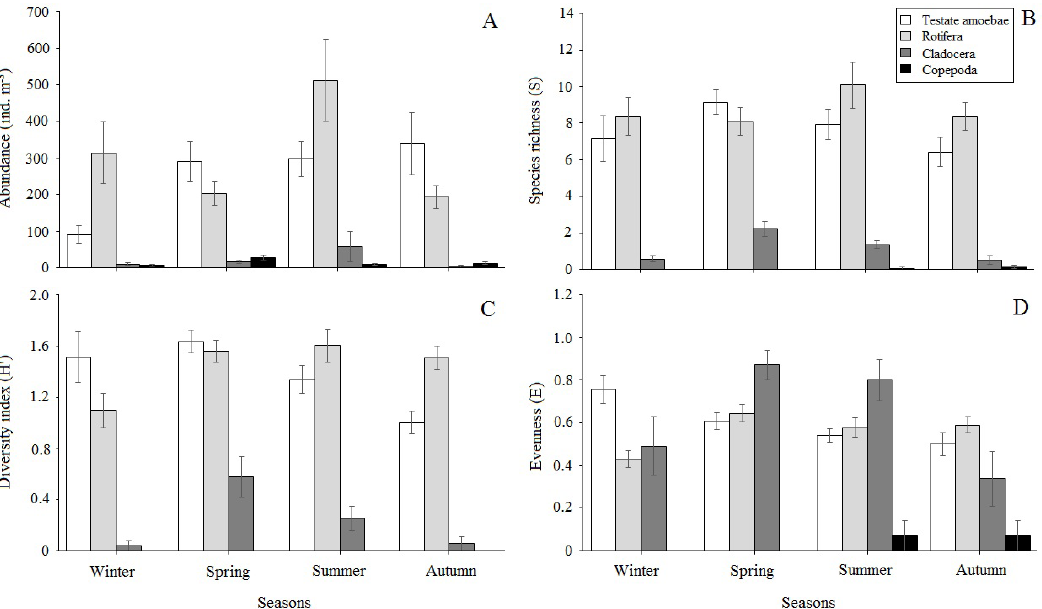
Figure 3. Mean values (±standard error) of (A) abundance, (B) species richness, (C) diversity and (D) evenness of Testate amoebae, Rotifera, Cladocera and Copepoda during the seasons in the Pelotas River sub-basin.